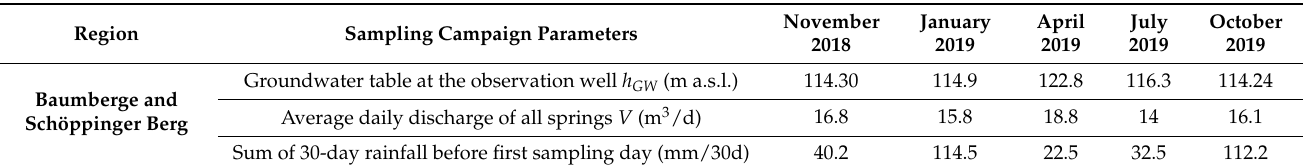
Table 3. Groundwater table, rainfall, and discharge at eight springs during the sampling period between November 2018 and October 2019.